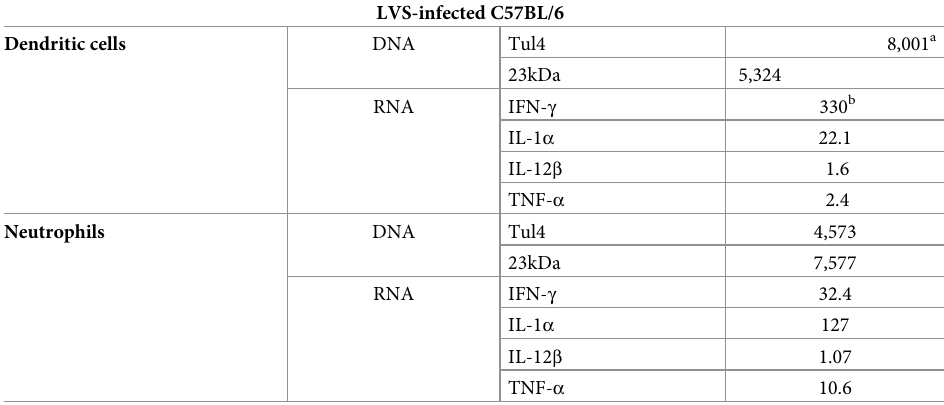
DNA from cells sorted to purify DC or neutrophils (see Materials and Methods, and S2 Fig) was amplified using Francisella -specific primers for Tul4 and 23kDA genes. Absolute quantifications were calculated using corresponding standard curves, using serial dilutions of DNA prepared from LVS. Bacteria were quantified using genomic equivalents (GE) where 1 ng DNA = 489,000 GE and 1 GE = 1 bacterium. a DNA data indicate GE per ~100 ng of total mouse and bacterial DNA. The upper limit of detection was 1 x 10 8 GE; the lower limit of detection was 1 x10 2 and 1 x 10 1 GE for Tul4 and 23kDa, respectively. Bacterial DNA was undetectable in cells from uninfected mice. DNA data represent average of two independent experiments. mRNA from sorted cells was purified and analyzed for gene expression by RT-PCR. b RNA data indicate median fold change compared to cells from uninfected mice, calculated from six independent experiments with sorted DC and five with